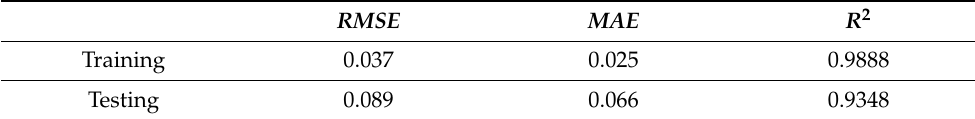
Table 3. Model performance indicators.